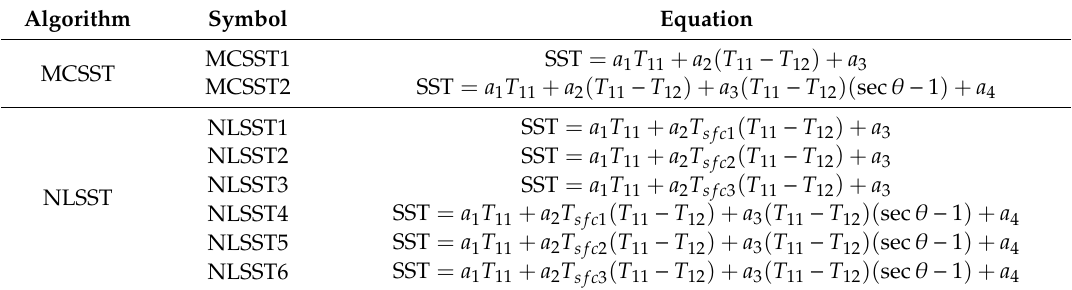
Table 2. Formula based on MCSST and NLSST algorithms ( T 11 and T 12 : Brightness temperature at 11 µ m and 12 µ m (in Celsius), T sfc 1 , T sfc 2 , and T sfc 3 : MCSST, OSTIA SST, and MURSST as